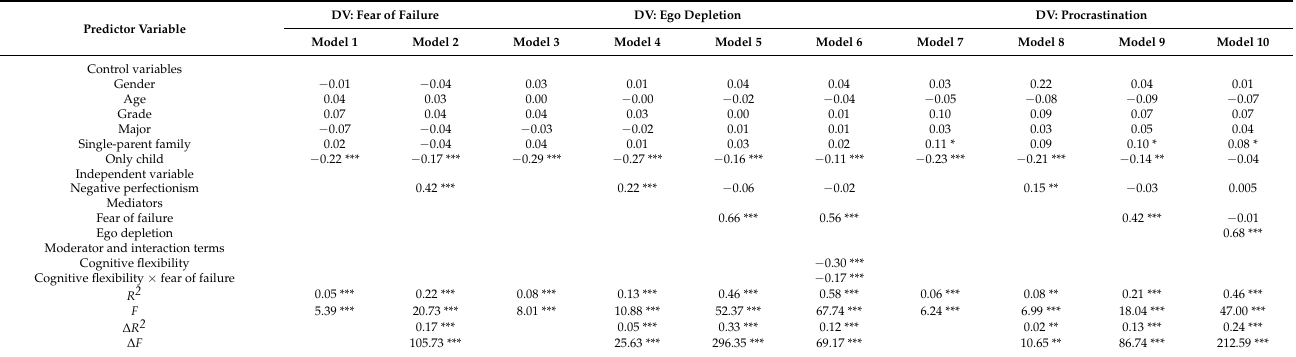
Table 3. Results of regression